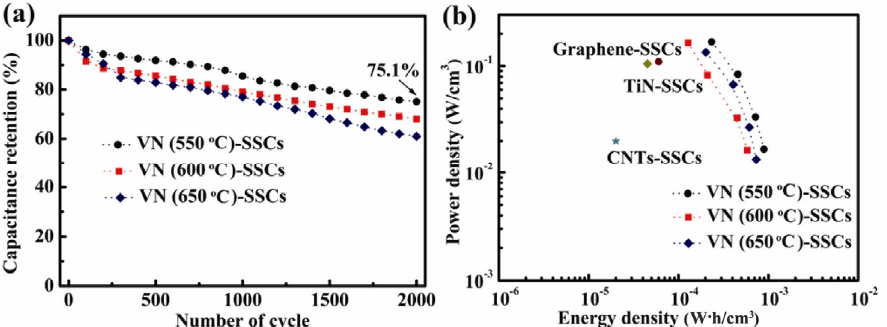
Fig. 8 (a) Cycle performance and (b) Ragone plot of VN nanofiber-based all-solid-state SCs. Energy and power densities of recently reported symmetric all-solid-state SCs are provided for